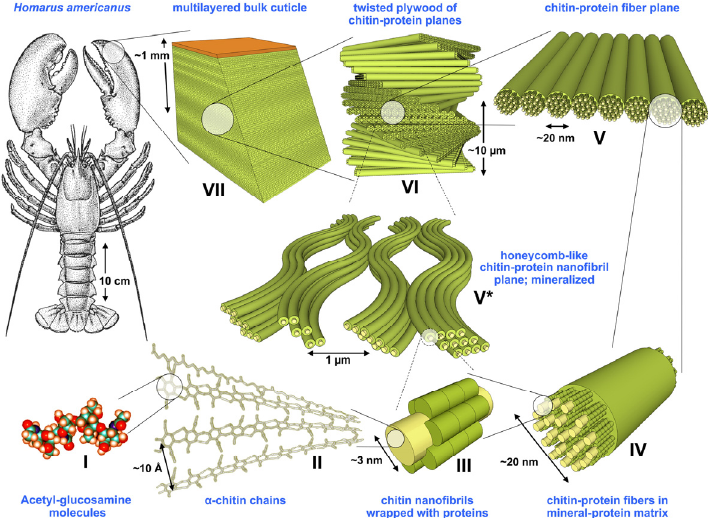
Figure 4. Structural hierarchy in an arthropod cuticle. Levels I to VII represent the general model assumed for the organic matrix in the cuticle; [17]. Reprinted from the Journal of the Mechanical Be- haviour of Biomedical Materials , 4/2, S. Nikolov, H. Fabritius, M. Petrov, M. Friák, L. Lymperakis, C. Sachs, D. Raabe, J. Neugebauer, Robustness and optimal use of design principles of arthropod exo- skeletons studied by ab initio-based multiscale simulations, 129–145, Copyright (2011), with per- mission from Elsevier.